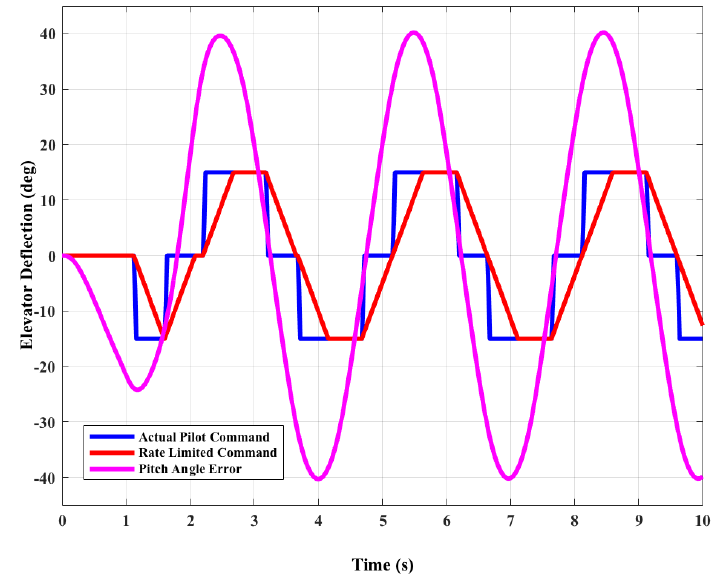
Figure 22. Simulation result for 31.46 ◦ /s elevator rate limit. Table 5. “Phastball” PIO susceptibility prediction result using simulation